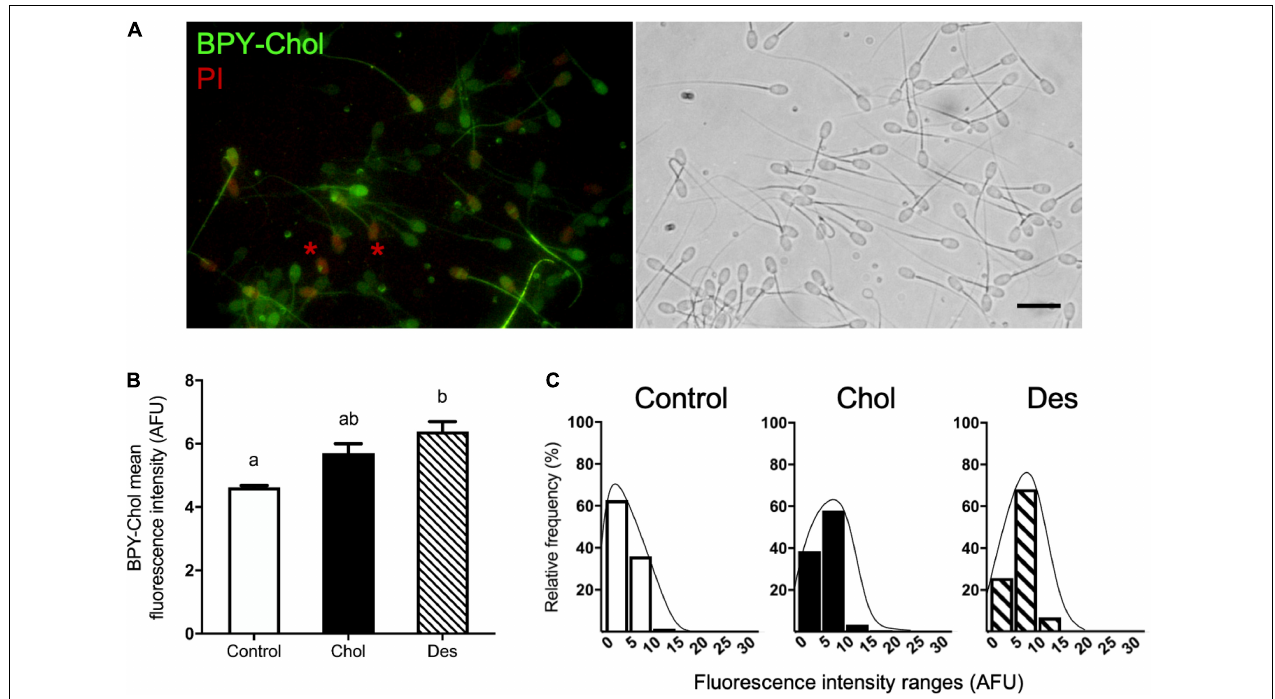
FIGURE 2 | Sterol distribution and content in cryopreserved ram spermatozoa estimated by BPY-Chol labeling of living cells. (A) Representative fluorescence image of BPY-Chol and PI in ram sperm with bright field on the right, scale bar represents 20 µ m. Asterisks indicate representative PI-positive stained sperm. (B) Sterol content of cryopreserved ovine spermatozoa after cholesterol (Chol) or desmosterol (Des) incorporation through treatment with 10 mM M β CD-sterol complexes. Results are expressed as arbitrary fluorescence units (AFU) and represent mean values ± SEM ( N = 5). Fluorescence measurements were automatized using masks in Fiji software. A total of 692, 451, and 864 cells were quantified for the control, Chol and Des groups, respectively. Data were analyzed by ANOVA and mean values were compared using the post hoc Bonferroni test. Different letters (a, b) indicate significant differences ( p < 0.05). (C) Histograms of the relative frequencies of BPY-Chol mean fluorescence intensity measured per spermatozoa and grouped in ranges of 5 AFU for each experimental group. Lines estimate unimodal histogram